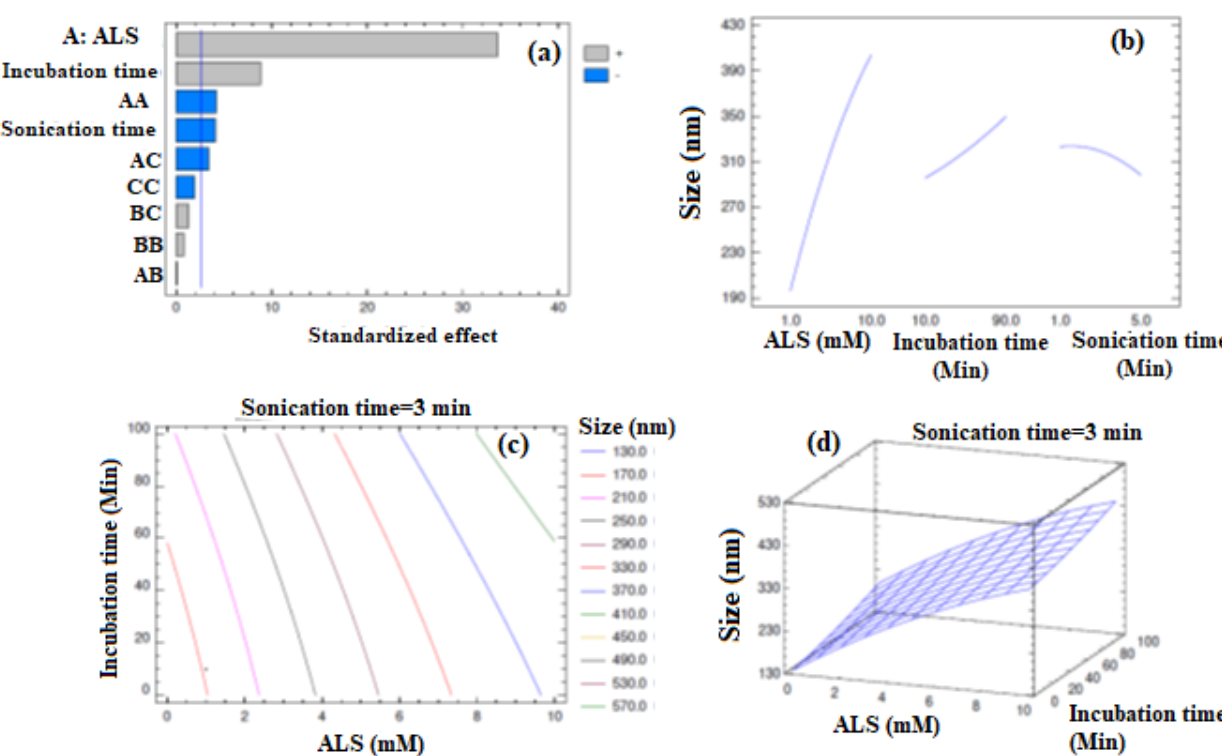
Figure 1. Design plots obtained for particle size of APA-ALS-NC formulations ( a ) standardized Pareto chart, ( b ) main effects plot, ( c ) contour plot, and ( d ) response surface plot.